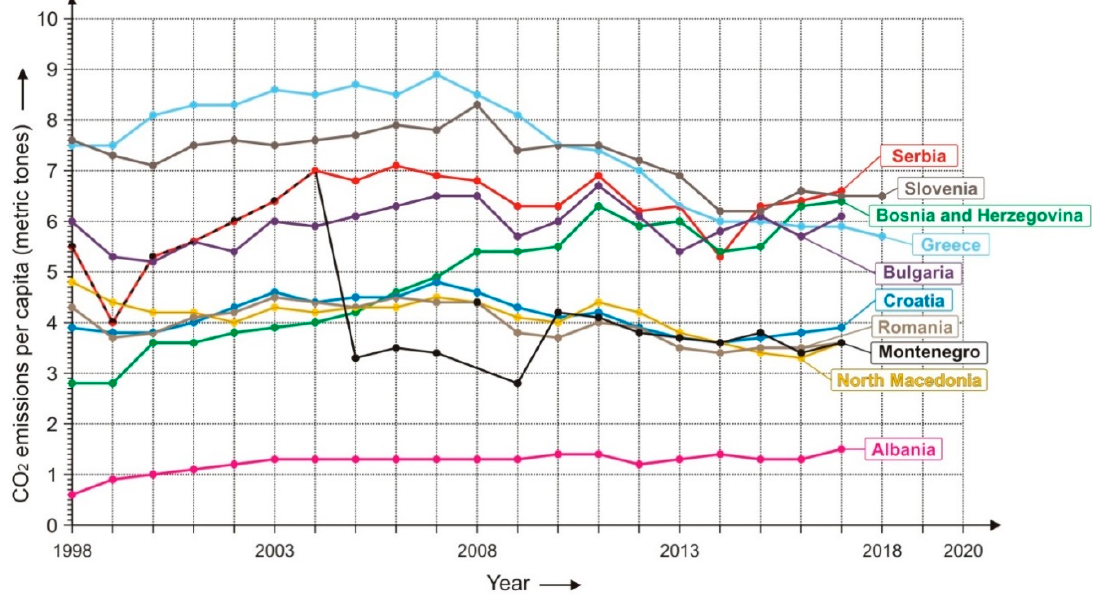
Figure 3. CO 2 emissions per capita in ten Balkan countries (1998–2019) (Authors’ creation).